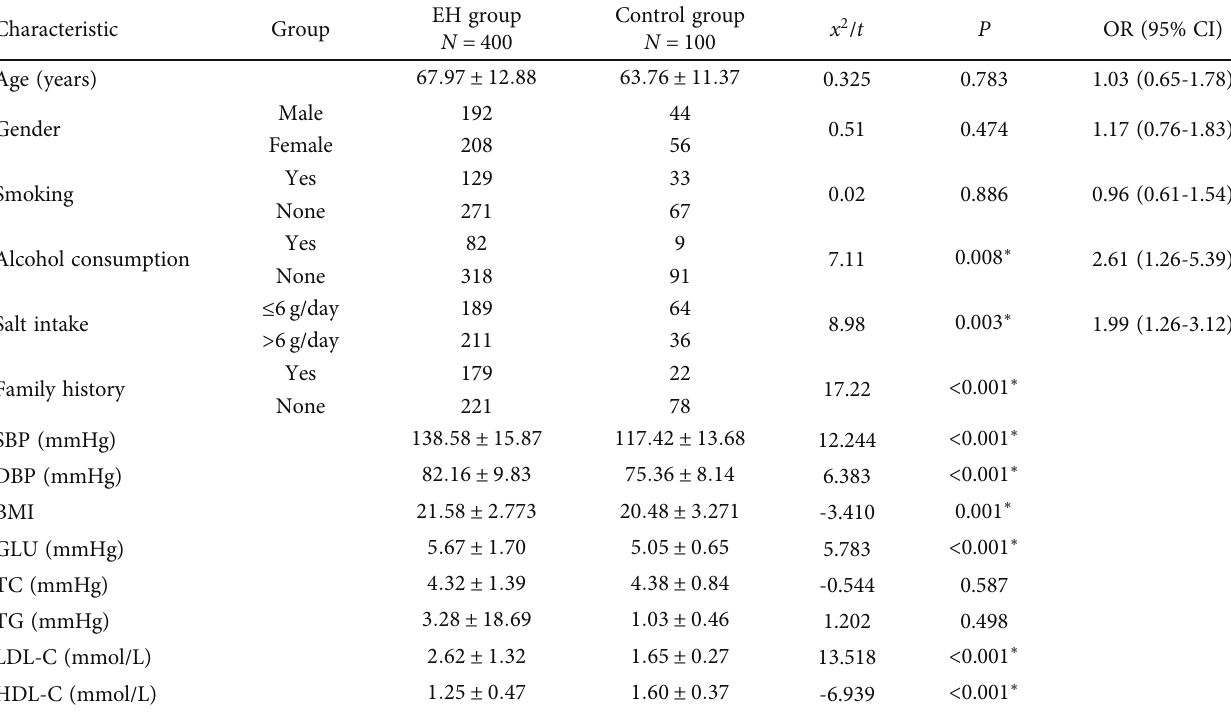
Table 2: Comparison of general clinical data between the EH and control